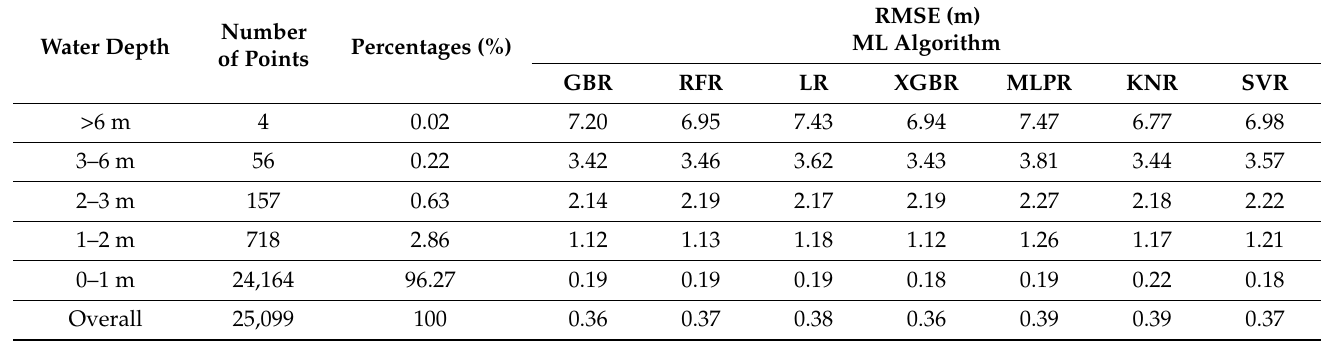
Table 3. Comparison of RMSE and regression techniques at various water depths.